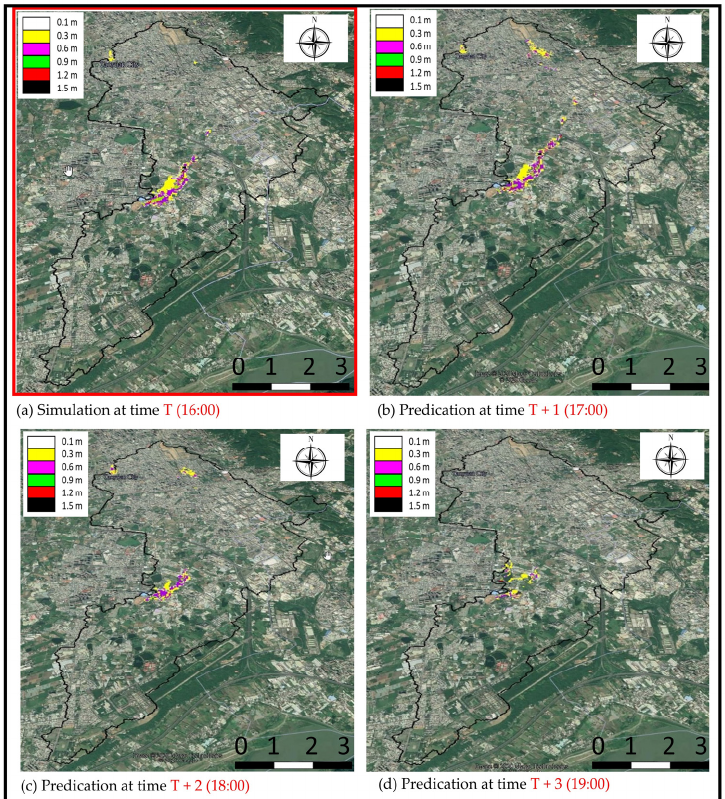
Figure 10. ( a ) The actual measured pluvial flood depths distributed over the study region, ( b ) closed-circuit television (CCTV) image caught at monitoring station 15 and ( c ) the AI simulated/predicted results presented by Google Earth. The red circle indicates the same location, at station 15, in the study region.